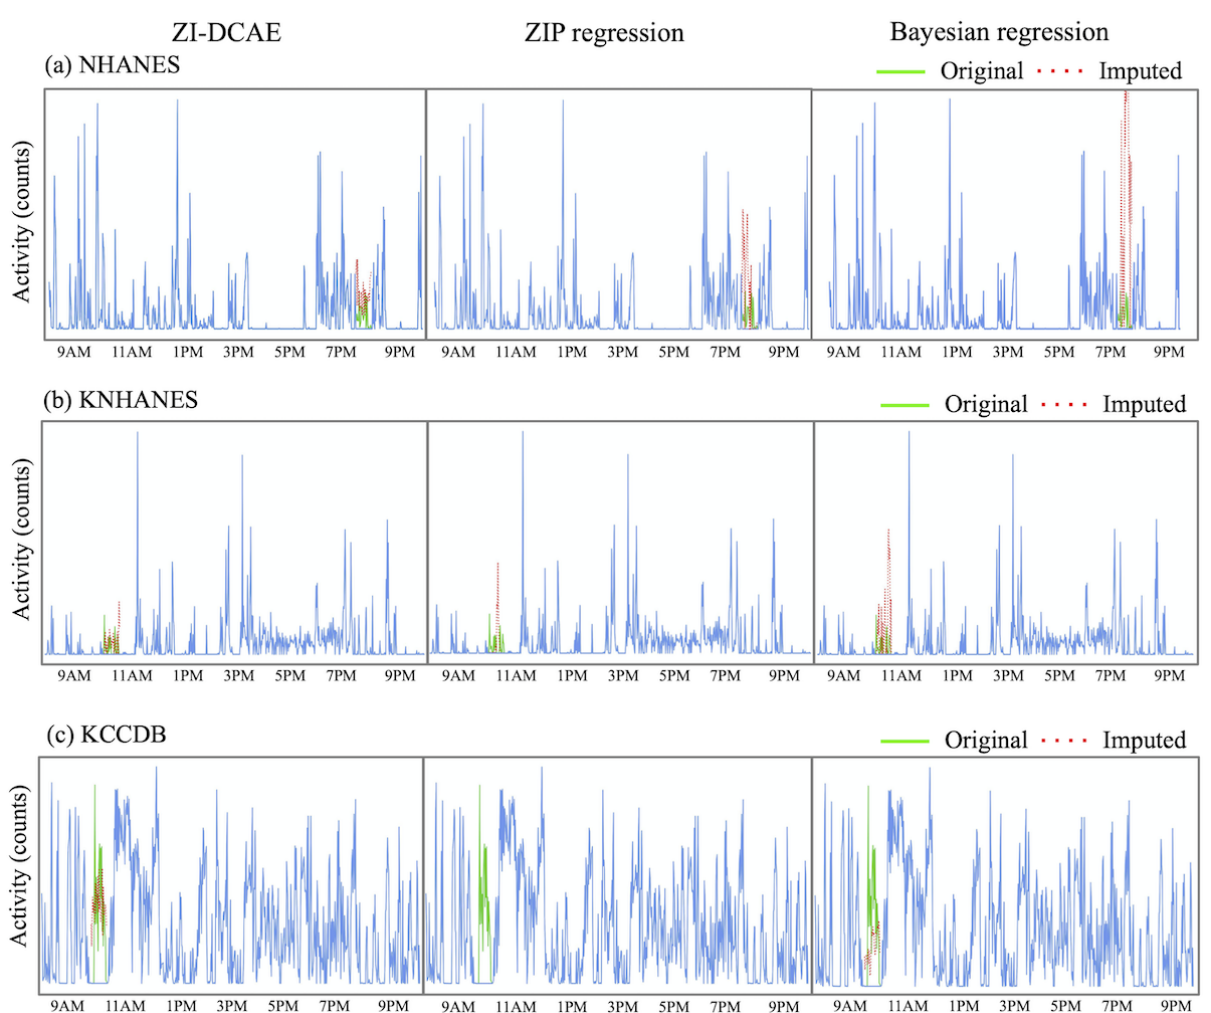
Figure 4. Examples of (a) NHANES, (b) KNHANES, and (c) KCCDB data sets for zero-inflated denoising convolutional autoencoder (left), zero-inflated Poisson regression (center), and Bayesian regression (right) with imputed (red) and original (green) intervals within the record (blue). KCCDB: Korean Chronic Cerebrovascular Disease Oriented Biobank; KNHANES: Korea National Health and Nutrition Examination Survey; ZI-DCAE: zero-inflated denoising convolutional autoencoder; ZIP: zero-inflated Poisson